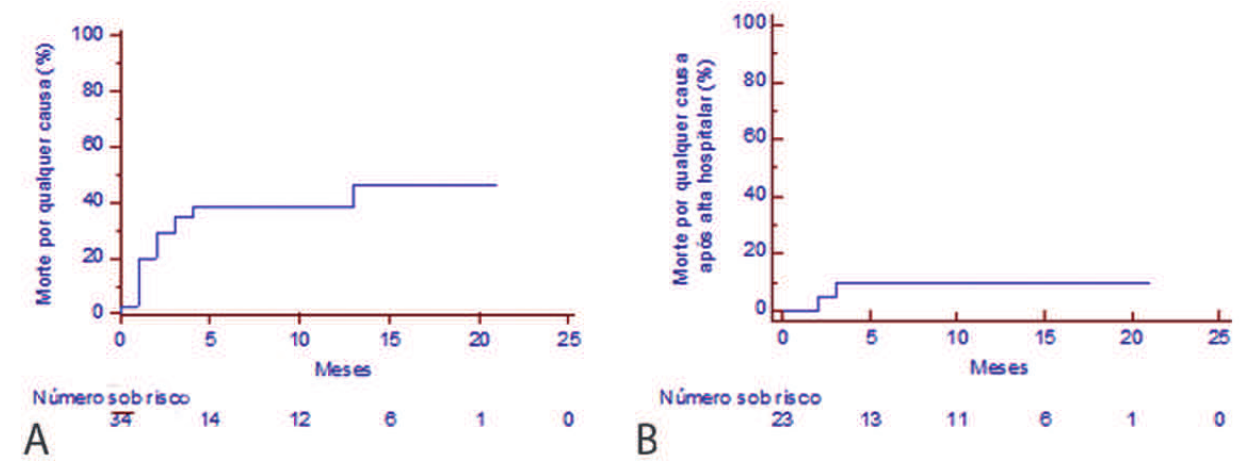
Fig. 2 – Curva de Kaplan-Meyer de mortalidade por qualquer causa e mortalidade após alta